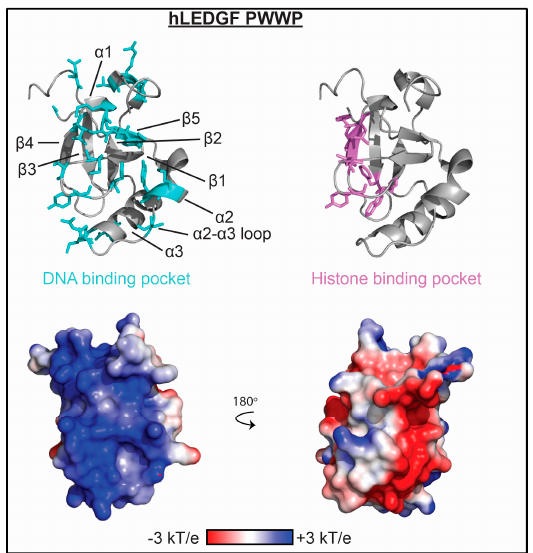
Figure 4. The molecular mechanism of PWWP association with nucleic acid. Residues determined to be important for binding nucleic acid as mapped by NMR spectroscopy and/or mutagenesis are shown as cyan sticks on ribbon representations of the LEDGF PWWP structure (PDBID 4FU6). Residues important for histone binding are shown as violet sticks. Corresponding representation of the electrostatic surface (determined using the APBS plug-in in pymol) is shown in two orientations. Unlike PHD fingers and BDs, the mode of DNA binding appears to be largely conserved among PWWP domains for which structural data is available. Primarily NMR spectroscopy studies have